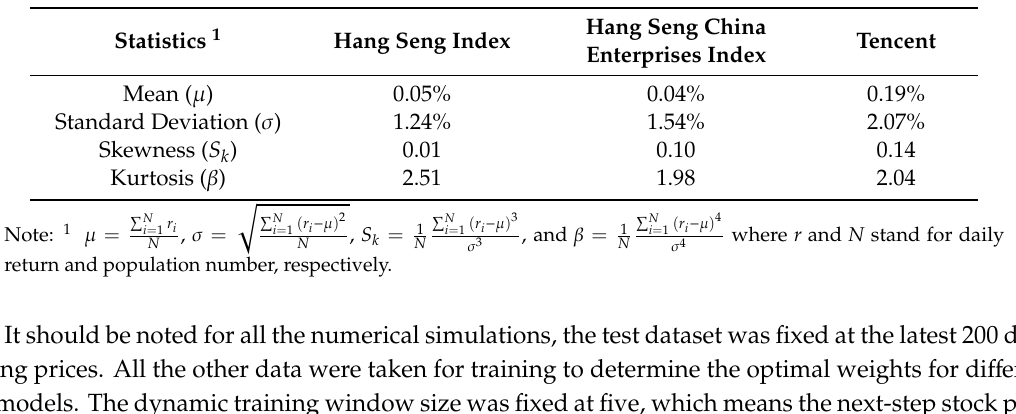
Table 6. Basic statistics of daily return of the three